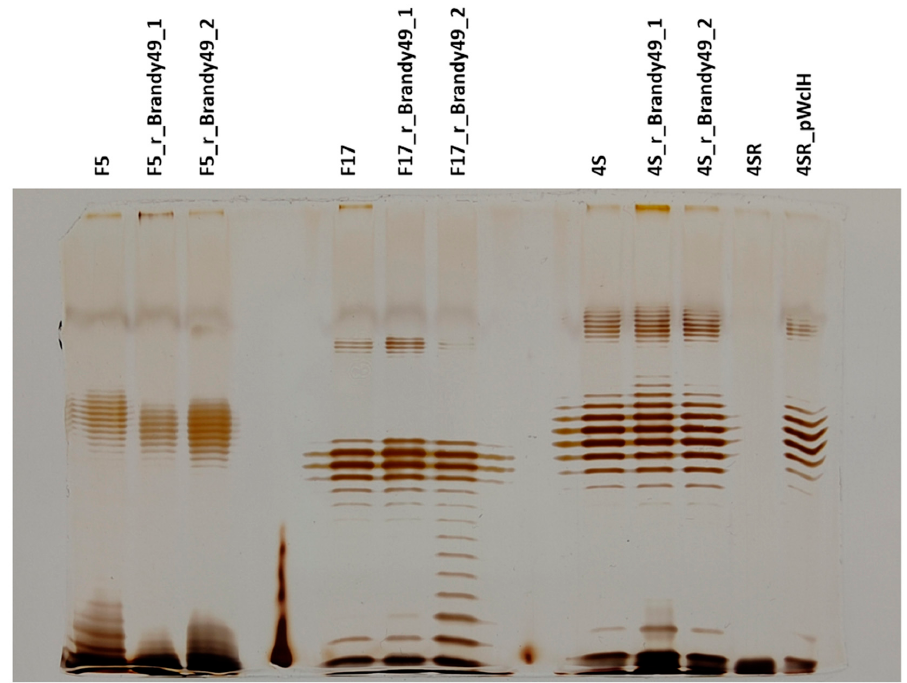
Figure 4. LPS profiles of the strains F5, F17 and 4s mutants, selected for the resistance to the phage Brandy49.